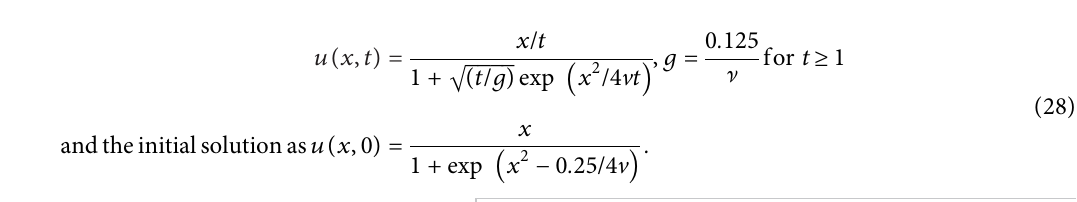
Figure 1: Numerical solution of the equation at diferent time